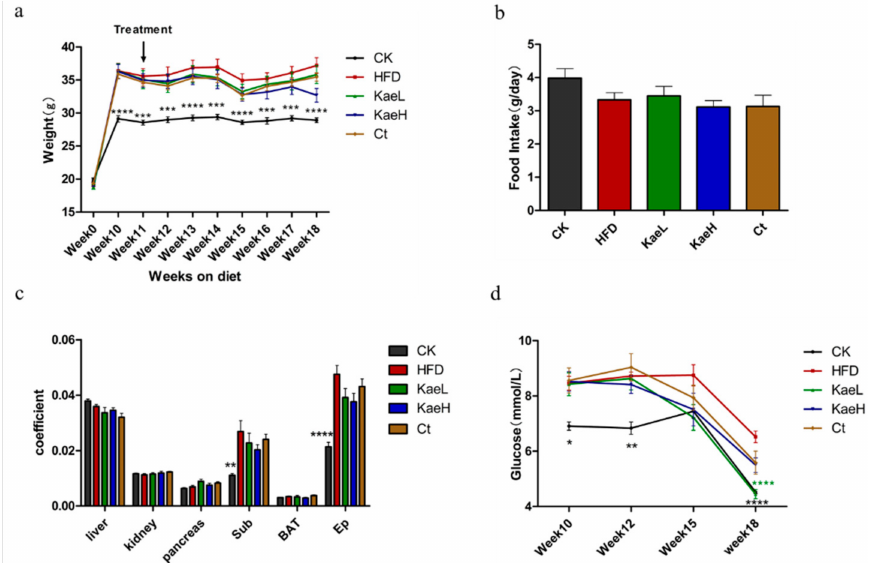
Figure 1. Effects of C. tinctoria and kaempferol on mouse physiology and glucose. ( a ) Weekly body weight of mice. ( b ) Mean daily food intake. ( c ) Organ coefficient. ( d ) Fasting blood glucose. Sub: subcutaneous fat, BAT: brown adipose tissue, Ep: epididymal fat, CK: control group, HFD: high-fat diet group, Ct: HFD+water extract of C. tinctoria group, KaeL: HFD+kaempferol low group, KaeH: HFD+kaempferol high group. Value = mean ± SD (n = 8). * p < 0.05 vs. HFD, ** p < 0.01 vs. HFD, *** p < 0.001 vs. HFD, **** p < 0.0001 vs.